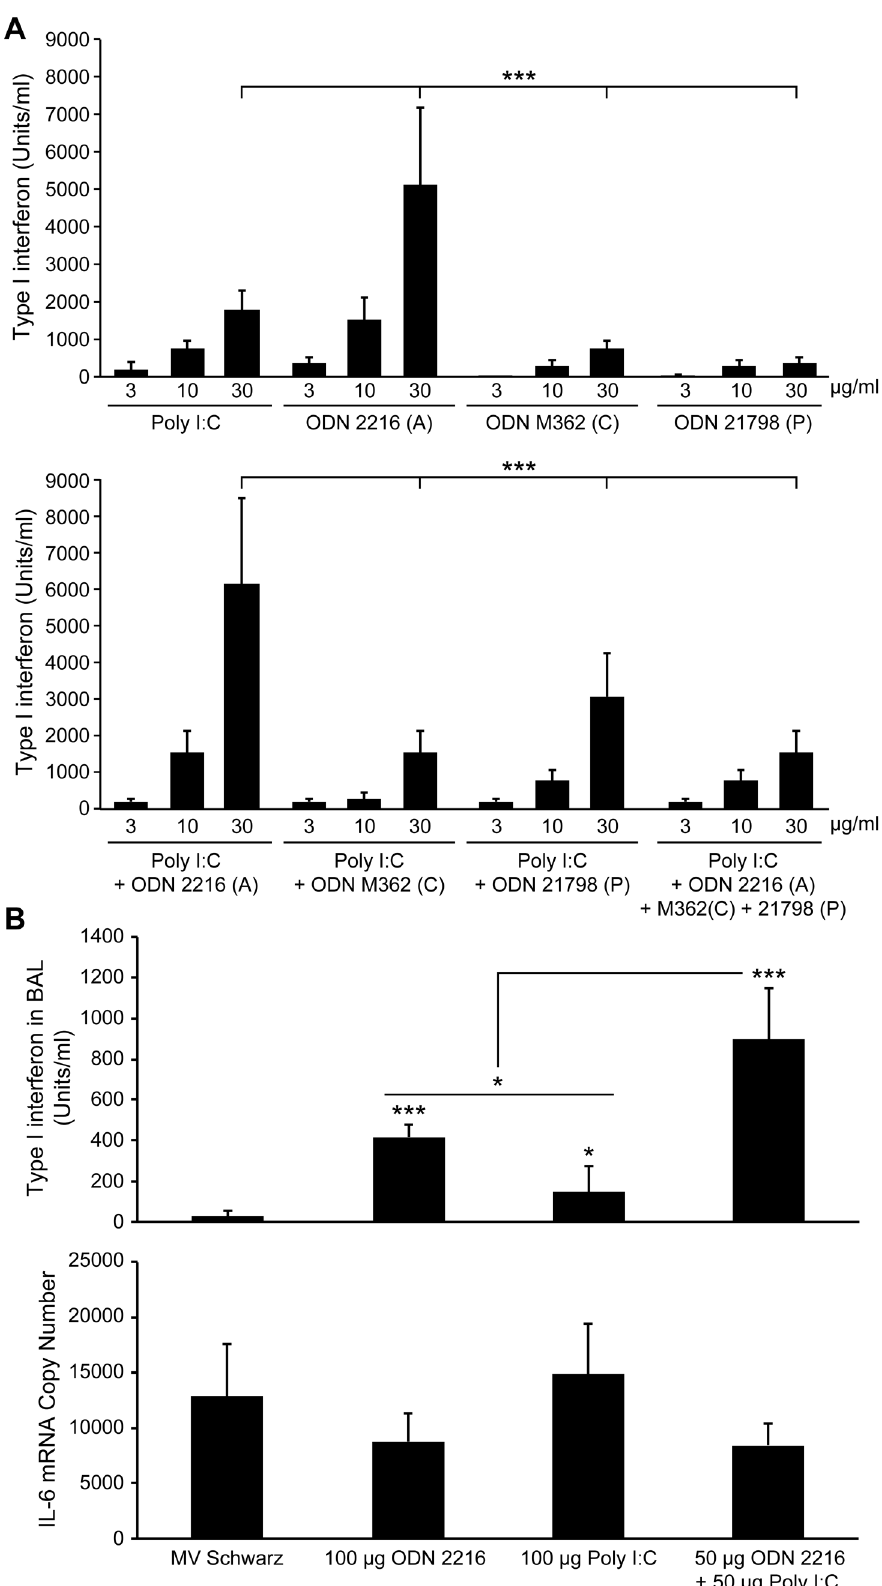
Figure 1. Synergistic effect of ODN 2216 and poly I:C on type I interferon induction in vitro and in vivo. (A) Bone-marrow derived cotton rat plasmacytoid dendritic cells were cultured with oligonucleotides for 24 hours, and type I interferon was measured from culture supernatant by bioassay. ODN 2216 (type A), M362 (type C) ODN 21789 (type P) and poly I:C were tested alone (upper panel) or in combination (lower